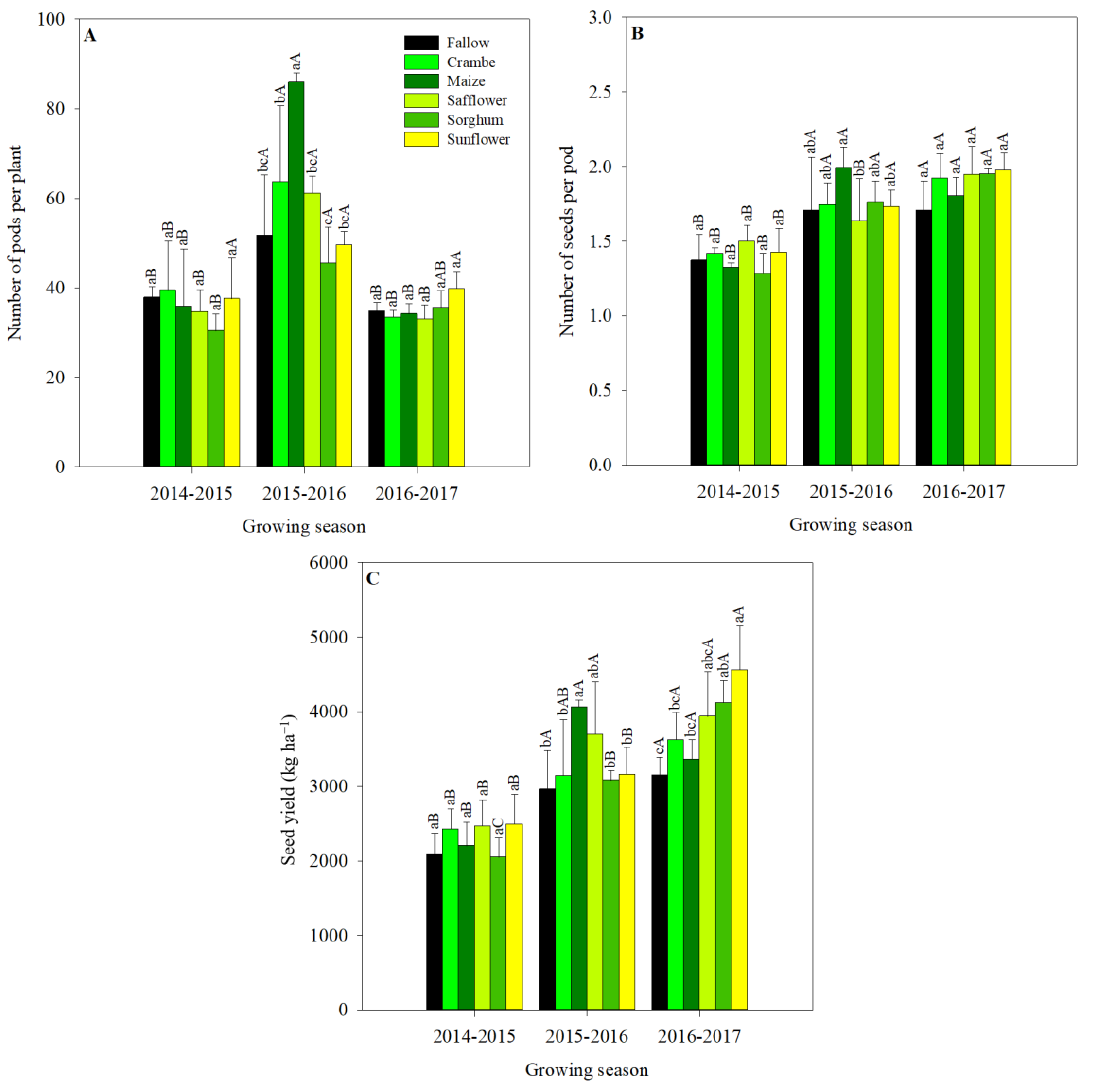
Figure 4. Growing season × previous crop interaction for number of pods per plant ( A ), number of seeds per pod ( B ), and seed yield ( C ) of spring–summer soybean crop. Error bars represent standard errors of the mean. Lowercase letters compare previous crops within each growing season, whereas uppercase letters compare growing seasons within each previous crop at p < 0.05 according to Tukey’s test. Table 4. Final plant population, number of pods per plant, number of seeds per pod, 1000-seed weight, and seed yield of spring – summer soybean crop following different fall – winter crops in three growing season, and analyses of variance.